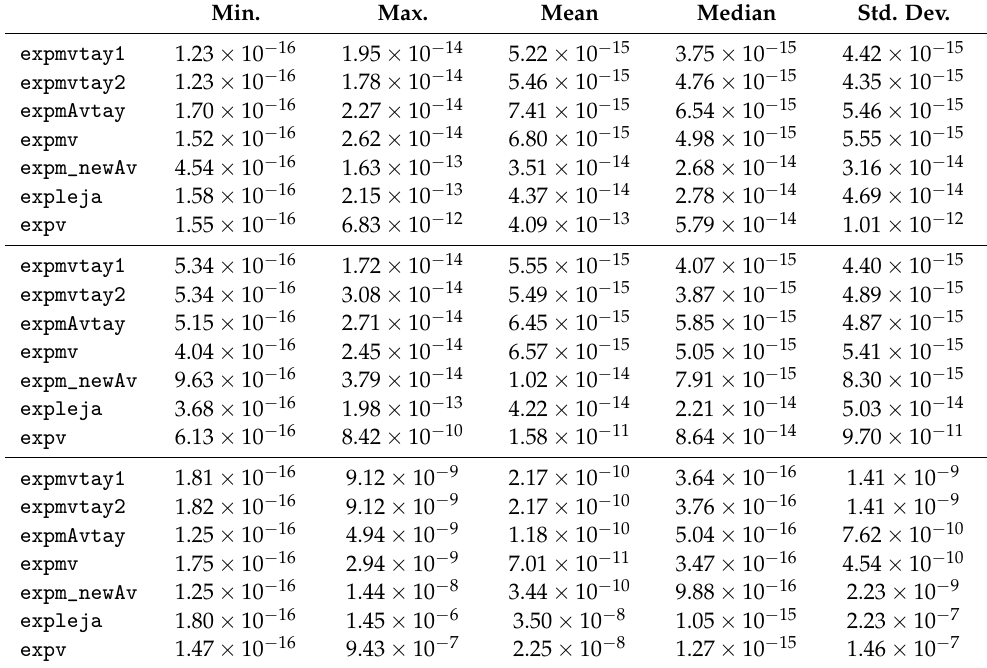
Table 3. Minimum, maximum, mean, median, and standard deviation values of the relative errors committed by all the codes for Sets 1, 2, and 3, respectively. Min. Max. Mean Median Std.